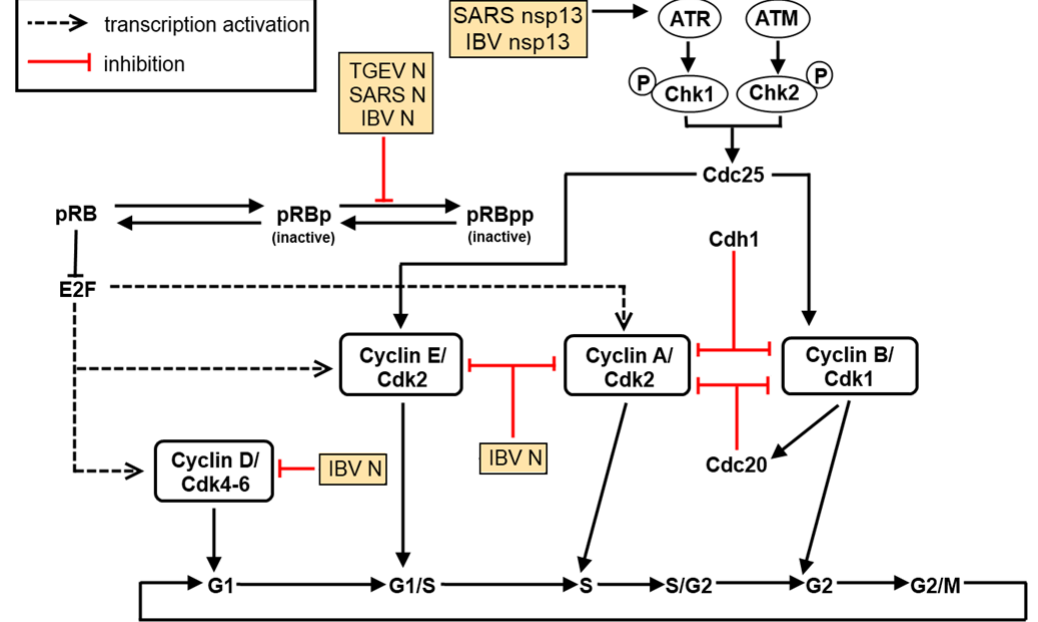
Figure 3. Coronavirus-encoded proteins interfere with the cell cycle. Cell cycle progression is mediated through the temporal expression levels of different cyclins and CDKs. Coronaviruses have been confirmed to cause cell cycle arrest at both G0/G1 and G2/M phases. This arrest is mediated through the nucleocapsid protein (N) as well as other virus-encoded non-structural (replicase) and accessory proteins such as